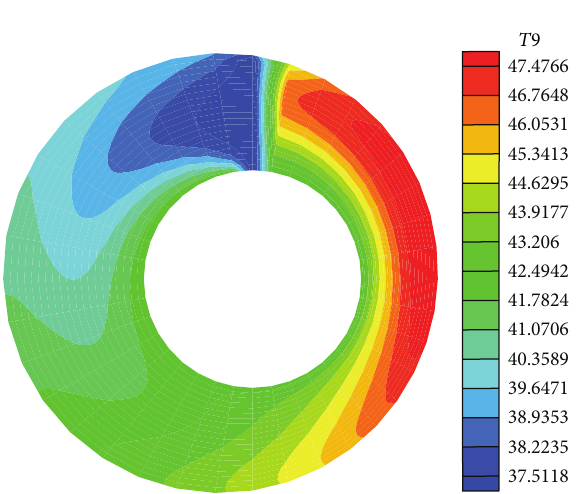
Figure 12: Isothermal lines of the journal bearing at its central plan for 𝜀 = 0.3 and 𝑛 = 1 .